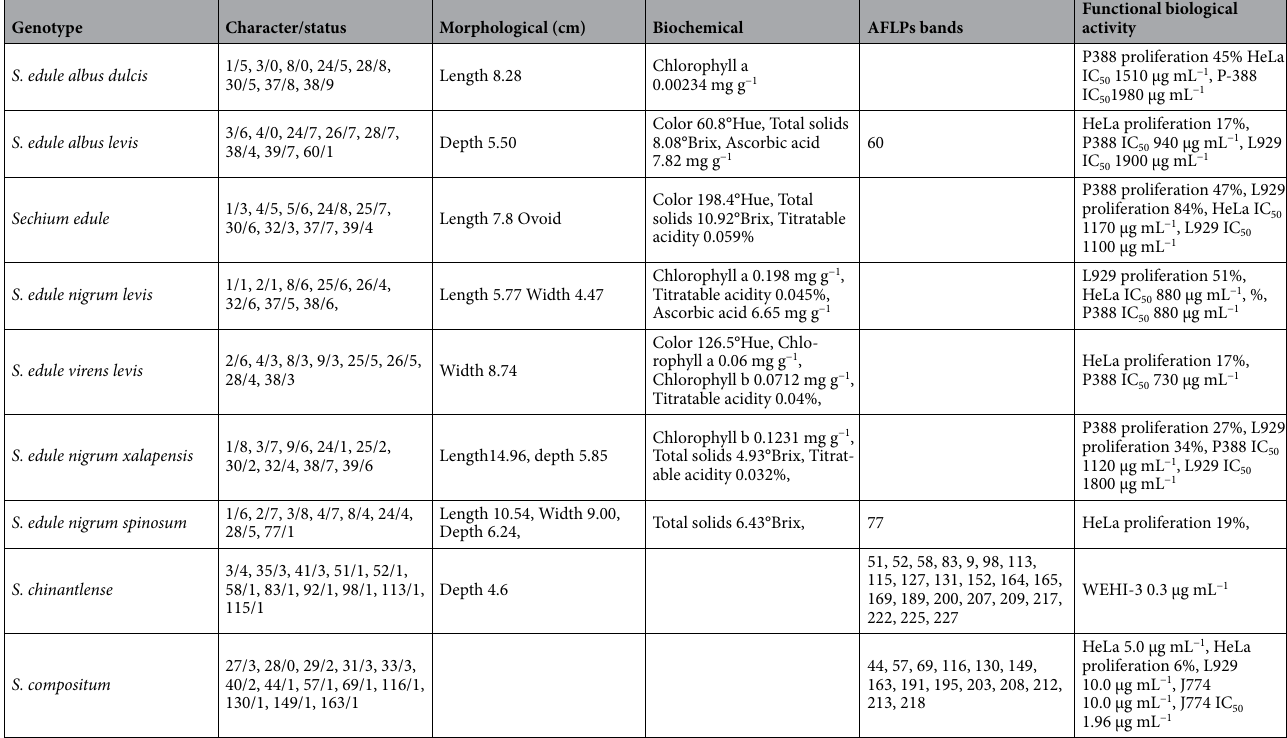
Table 3. Symplesiomorphic characters from the heuristic clade generated from morphological, biochemical, and genetic variables of ten Sechium spp. genotypes.